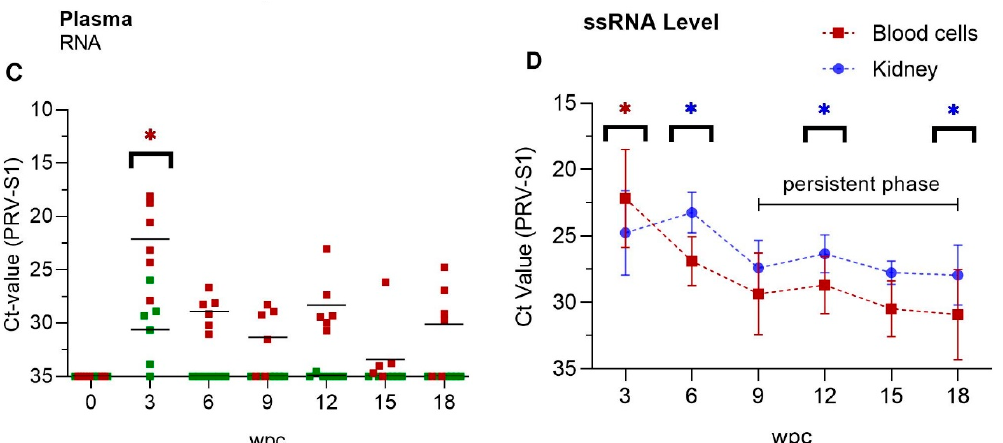
Figure 2. PRV-1 dsRNA and ssRNA levels. Mean Ct-values of RT-qPCR (PRV-S1) for ( A ) Blood cells, ( B ) Kidney and ( C ) Plasma. RNA was pre-heated (red dots) or not (green dots), indicating presence of viral dsRNA plus ssRNA transcripts or ssRNA PRV transcripts only, respectively. n = 6 for each time point. Statistical analysis between denaturated and not-denaturated samples from the same RNA was performed by non-parametric, Wilcoxon matched pairs signed rank test. Asterisk shows significantly high level (* p < 0.05) ( D ) Paired analysis of ssRNA Ct-values (Table S1) of kidney compared to blood cells in persistent phase (9 wpc -18 wpc). Each dot shows mean Ct-value at each time point. Statistical analysis was performed by non-parametric, Wilcoxon matched pairs signed rank test ( p < 0.05), asterisk (red/blue) indicates significantly different group.). wpc = weeks post challenge.